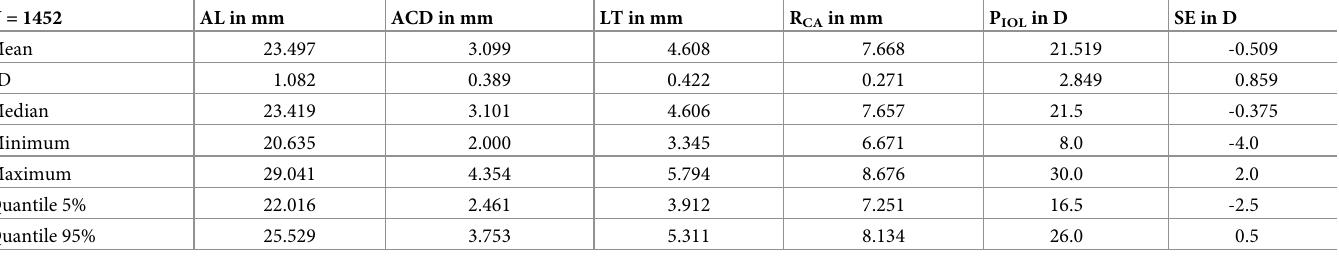
Table 1. Descriptive statistics of the entire dataset with mean, standard deviation (SD), median, minimum and maximum, 5%, and 95% quantiles (90% confidence